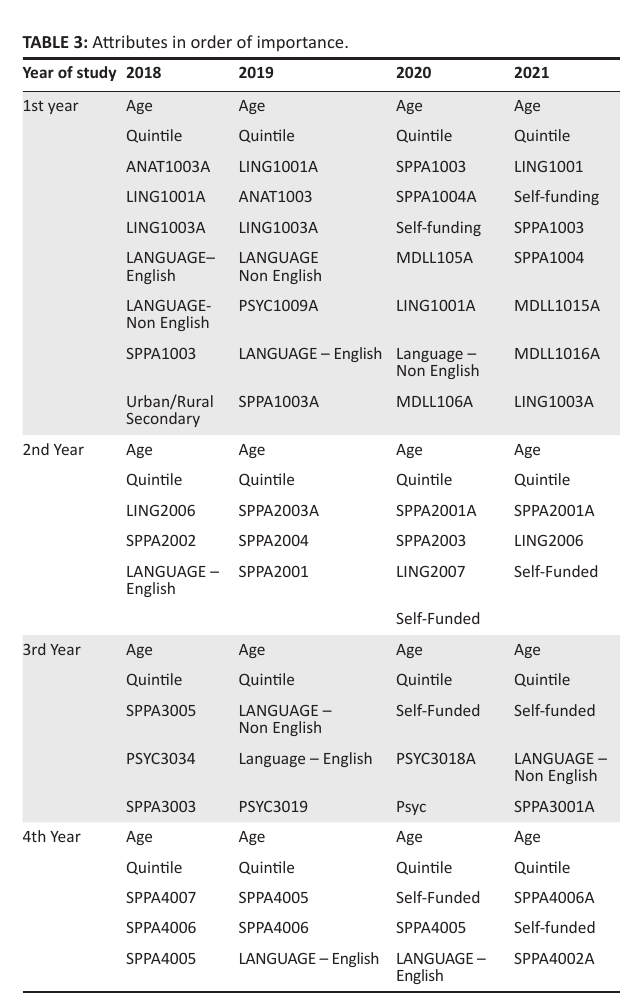
FIGURE 8: Fourth-year 2021 important